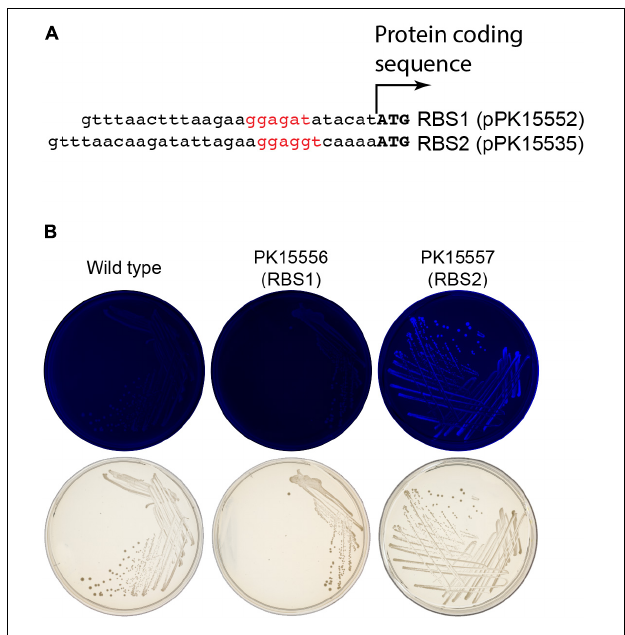
FIGURE 6 | Enhancement of gfp expression to increase colony fluorescence. (A) Comparison of the ribosome binding sites (rbs) from pPK15535 plasmid containing the optimized gfp compared to the original suicide plasmid pPK15552, in which gfp possessed a ribosome binding site from pRL814. This latter variant failed to produce detectable fluorescence in Z. mobilis in single copy. The RBS was improved using the Salis program (Salis et al., 2009; Borujeni et al., 2014). (B) Top plates show the fluorescence images of colonies from indicated integrated plasmids strains excited at 490 nm and imaged at 510 nm. Bottom plates show the same colonies viewed with visible light. Only the cells possessing GFP translated from the improved RBS have detectable